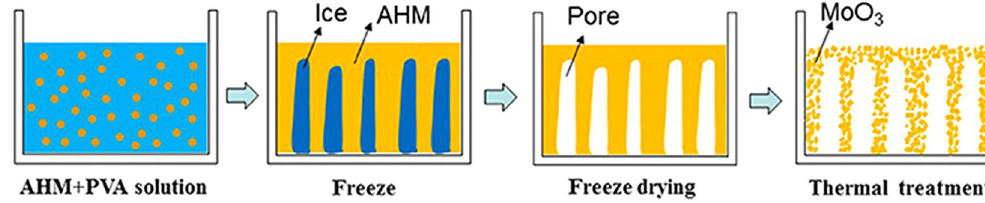
Figure 12. Schematic mechanisms of freeze-drying process and sintering